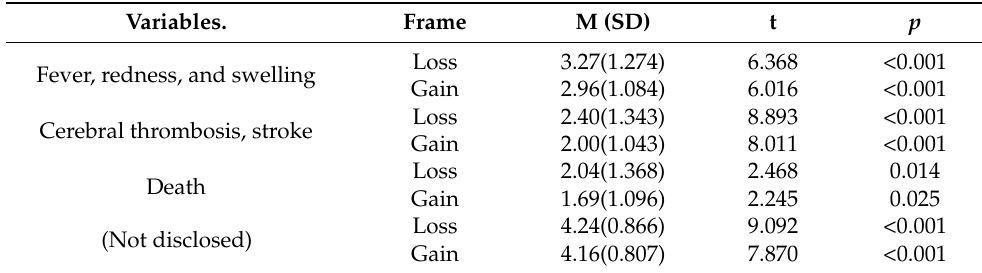
Table 7. Effect of risk disclosure on vaccination intention.